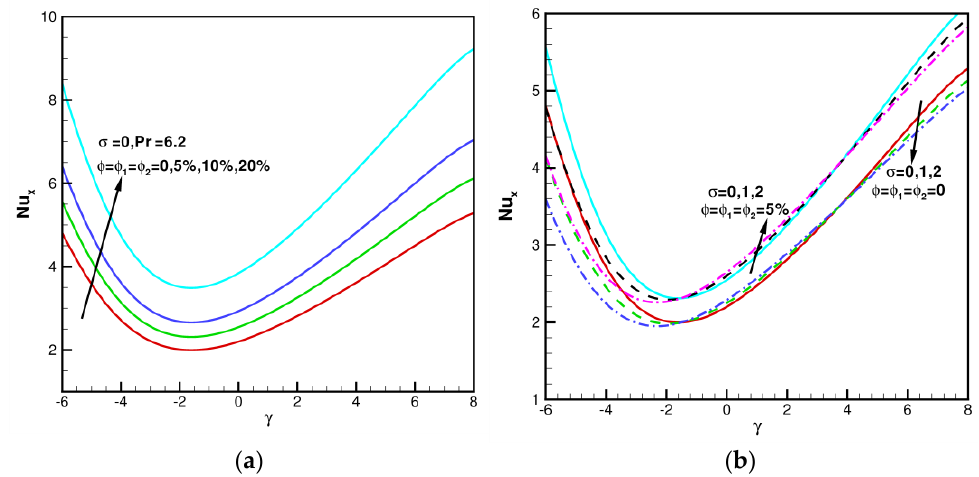
Figure 6. Local Nusselt number Nu x for various γ , φ , and σ when Pr = 6.2. ( a ) Impact of σ = 0, φ = φ 1 = φ 2 = 0, 5%, 10%, 20%; ( b ) Impact of φ = φ 1 = φ 2 = 0, 5%, σ = 0, 1, 2.